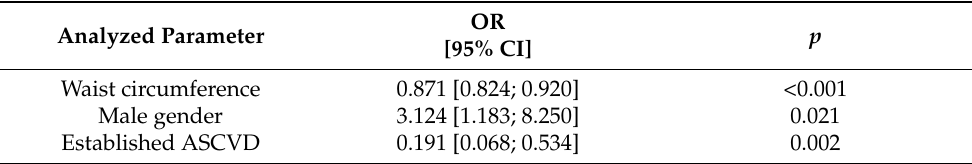
Table 4. Predictors for moderate-to-severe OSA risk in patients with T2DM. Analyzed Parameter